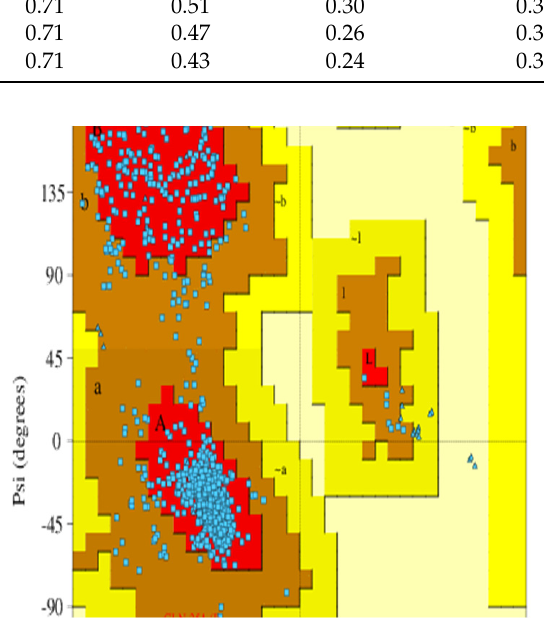
Figure 2. Ramachandran plot of the homology model. The red, brown, yellow, and light-yellow regions represent the most favored regions, additionally allowed regions, generously allowed regions, and disallowed regions, respectively. The residues are shown as blue dots.